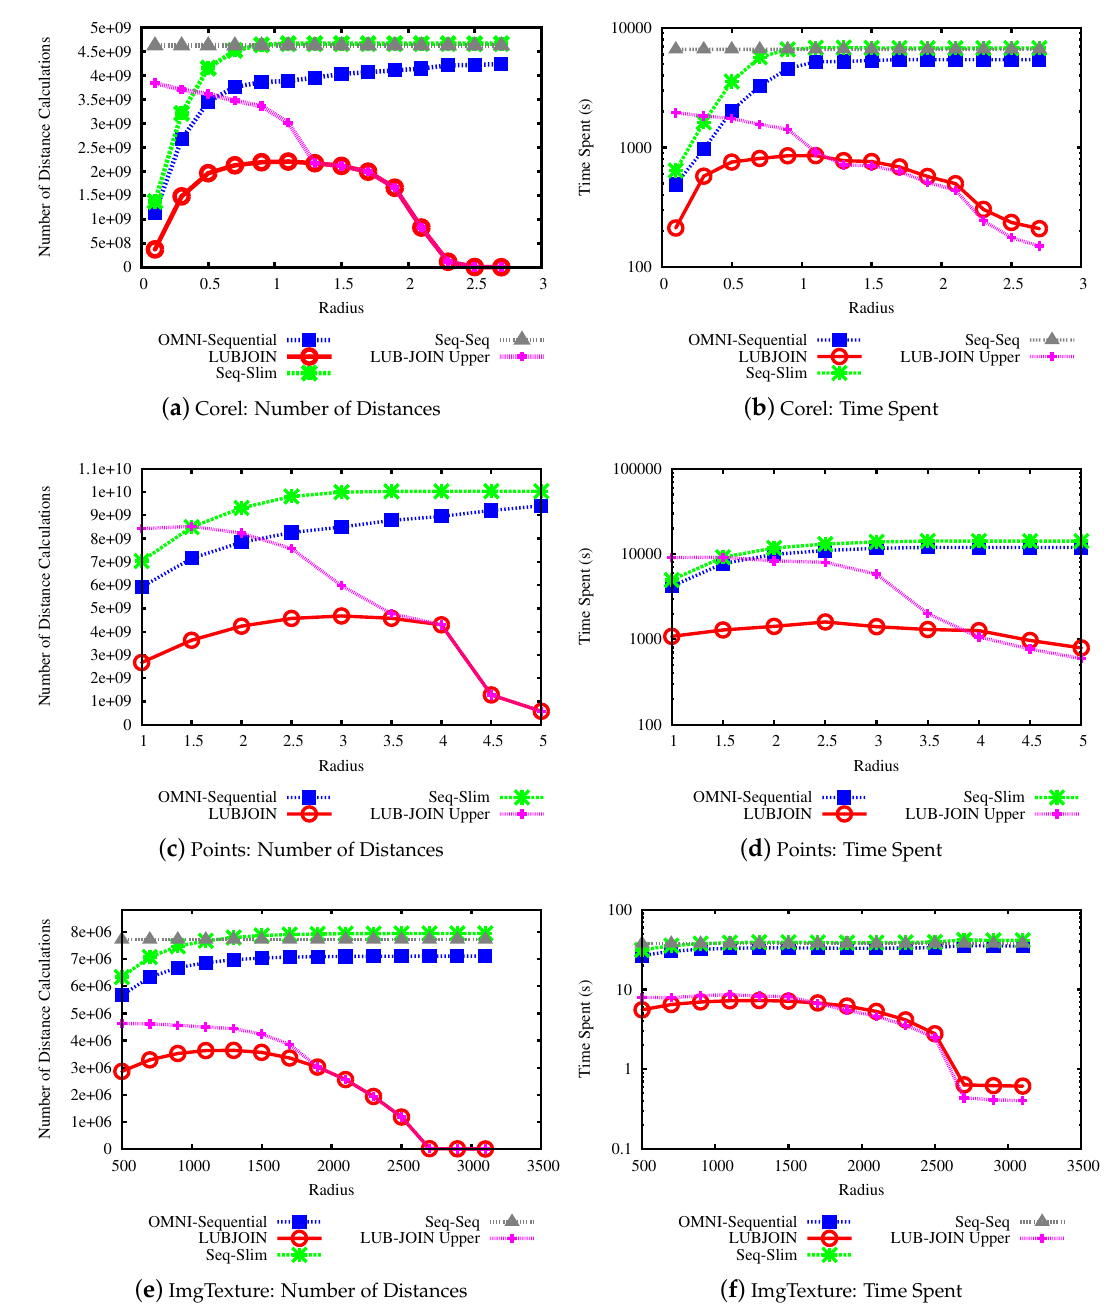
Figure 9. Performance of similarity joins for LUBJOIN. ( a , c , e ) the average of the number of distances calculated in queries. ( b , d , f ) the time spent for performing the queries